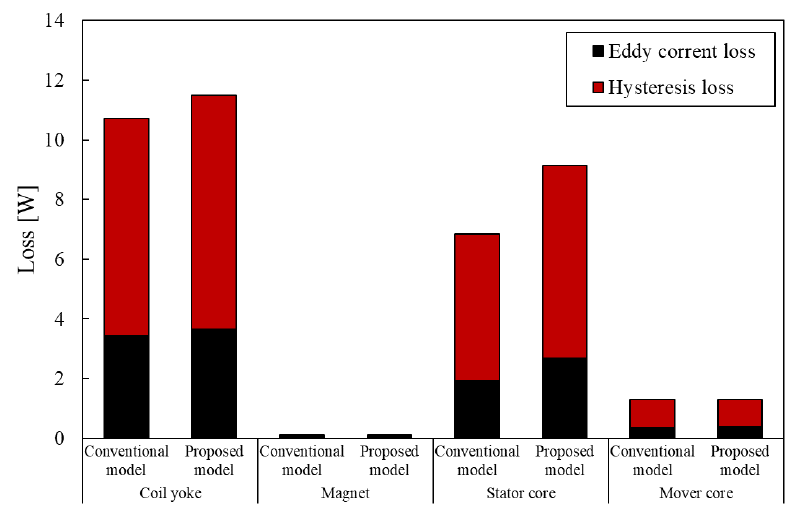
Figure 12. Breakdown of Irion